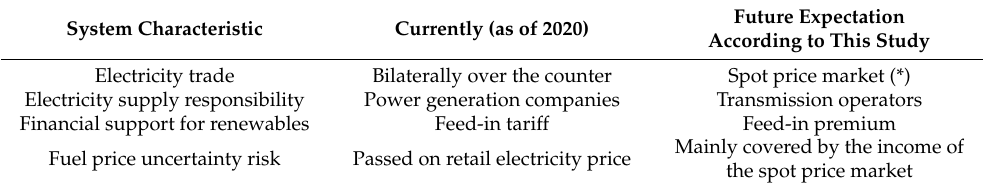
Table 2. Current and future electric utility system in Japan.